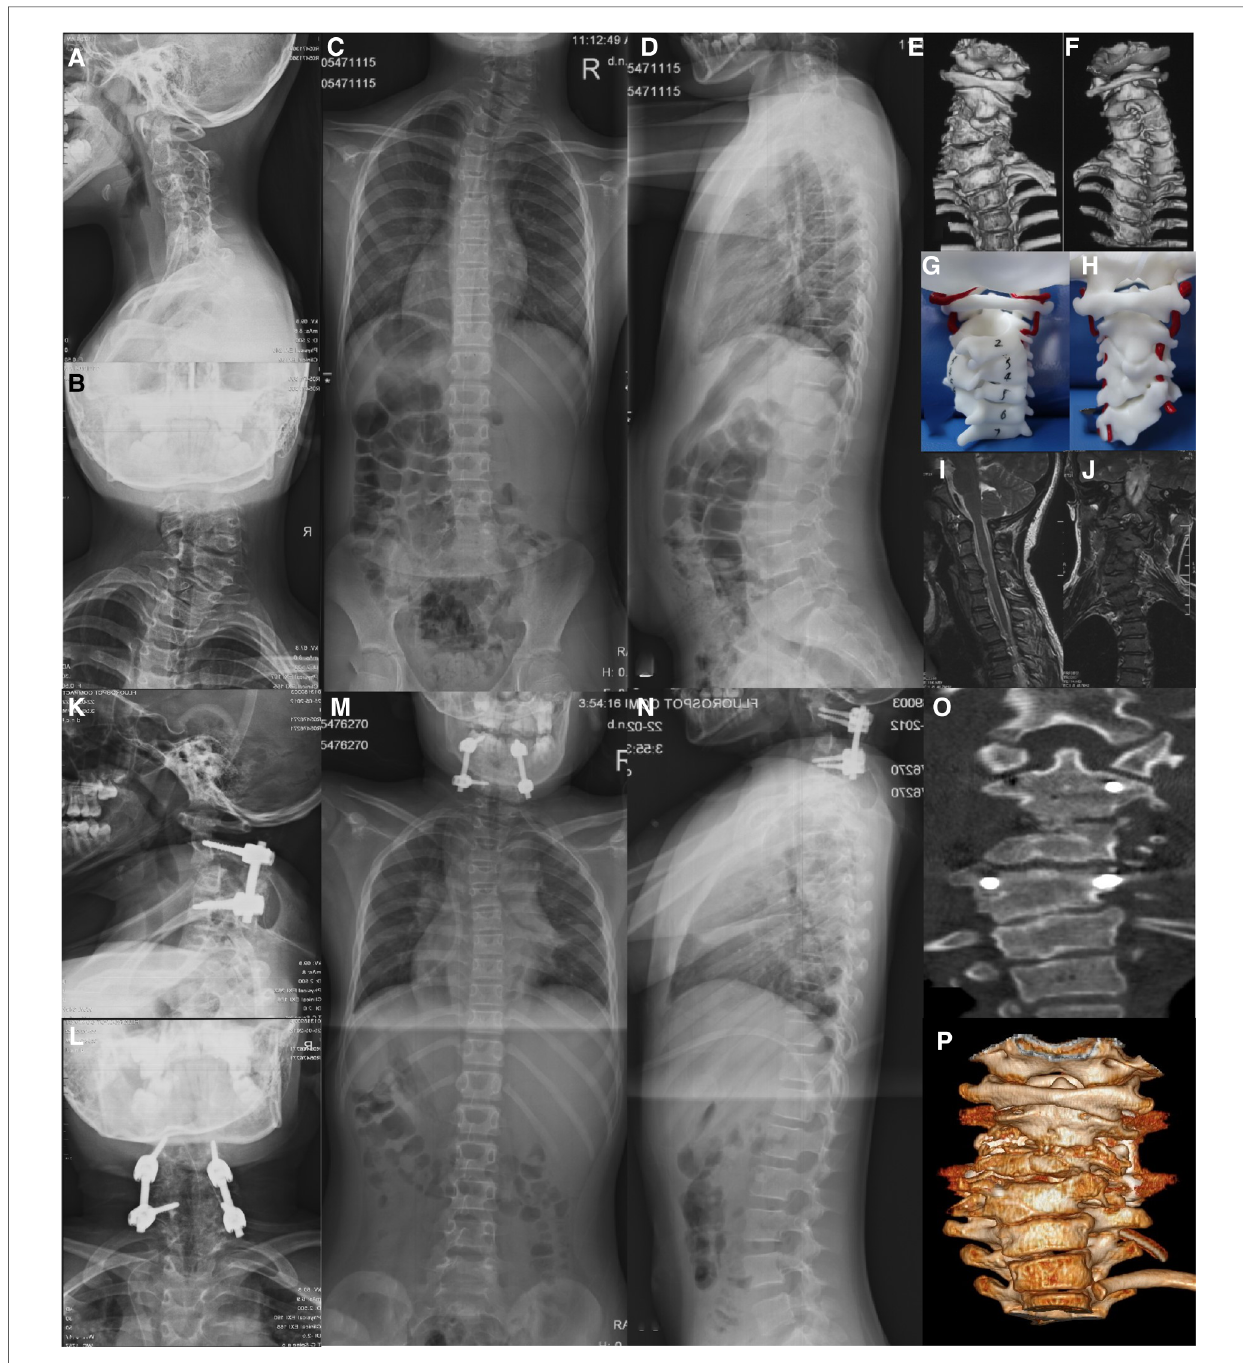
FIGURE 5 A case of Type IIB cervical hemivertebra, female, 9 years old. ( A – J ): C3, C4 right hemivertebrae, C2 and C5 are fused on the concave side; Figures ( K – P ): A-P approach resection of C3, C4 hemivertebrae, C2-C5 fi xed and fused, 2 postoperative year